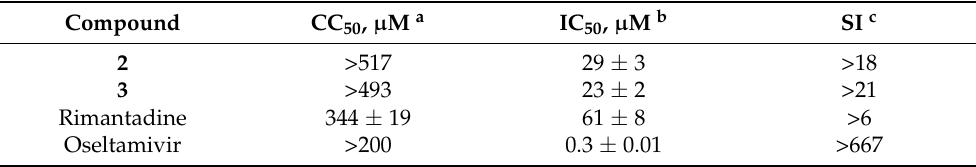
Table 1. Cytotoxicity and anti-influenza data of the derivatives 2 and 3 . Compound CC 50 , µ M a IC 50 , µ M b SI c 2 >517 29 ± 3 >18 3 >493 23 ± 2 >21 Rimantadine 344 ± 19 61 ± 8 >6 Oseltamivir >200 0.3 ± 0.01